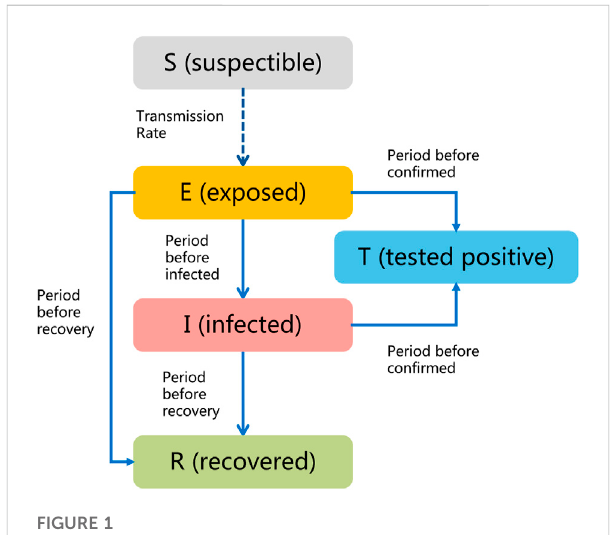
FIGURE 1 SEITR model transmission